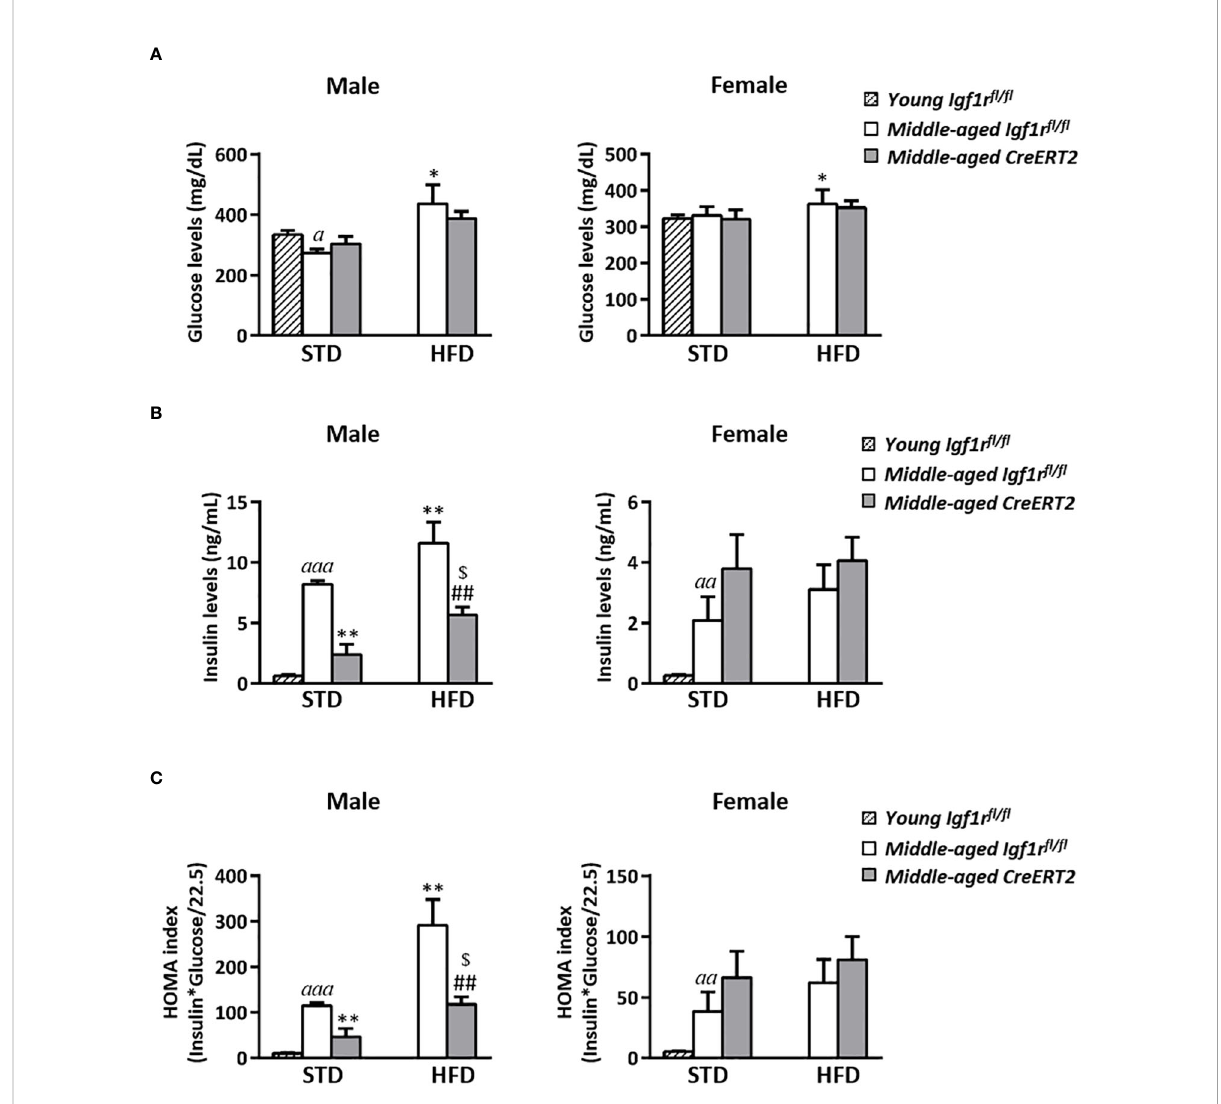
FIGURE 6 Glucose homeostasis in middle-aged male IGF1R-de fi cient mice. Serum levels of glucose (A) and insulin (B) ; and insulin resistance index (HOMA) (C) in CreERT2 IGF1R-de fi cient middle-aged male and female mice compared to their Igf1r fl / fl counterparts and to young (13 weeks- old) Igf1r fl / fl on STD. Data are expressed as mean ± SEM of at least 4 animals per group (n= 4-11 mice per group). a p < 0.05, aa p < 0.01 and aaa p < 0.001 vs . young Igf1r fl / fl STD mice. *p < 0.05, **p < 0.01 vs . middle-aged Igf1r fl /f STD animals; ## p < 0.01 vs. middle-aged Igf1r fl / fl HFD mice; and $ p < 0.05 vs. middle-aged CreERT2 STD